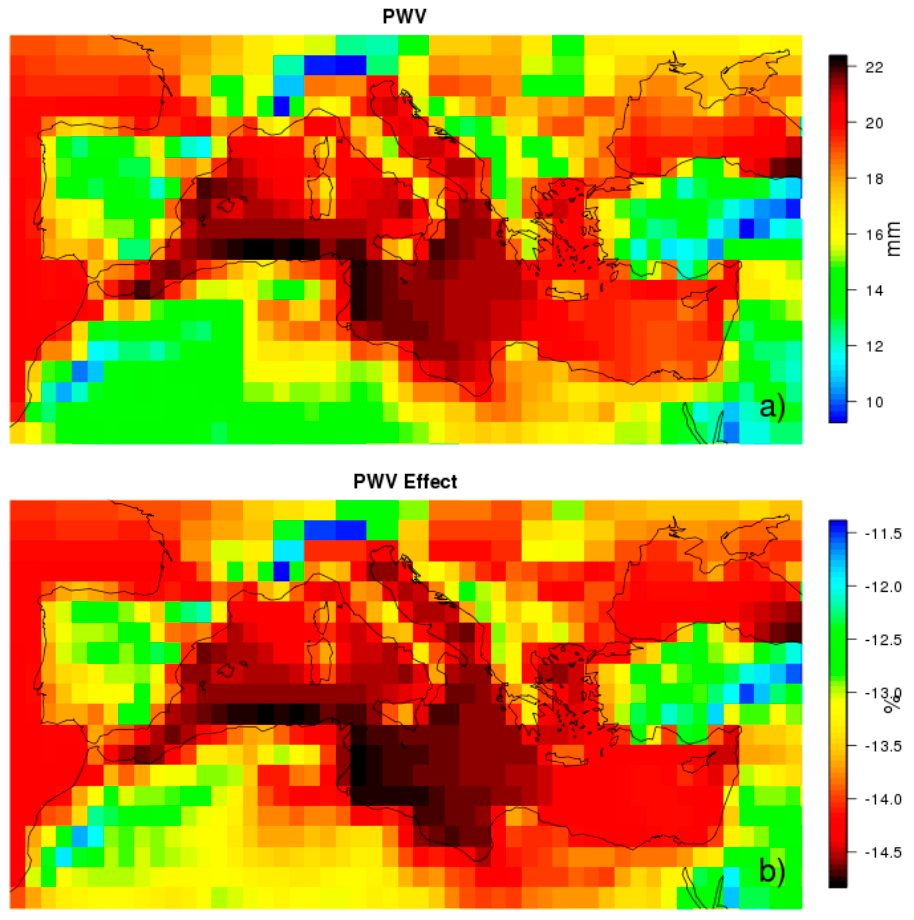
Figure 3. Distribution of averaged (a) PWV (mm) and (b) PWV effects on shortwave radiation at the surface over the Mediterranean basin during the period 2000–2018. Remote Sens. 2020 , 12 , x FOR PEER REVIEW